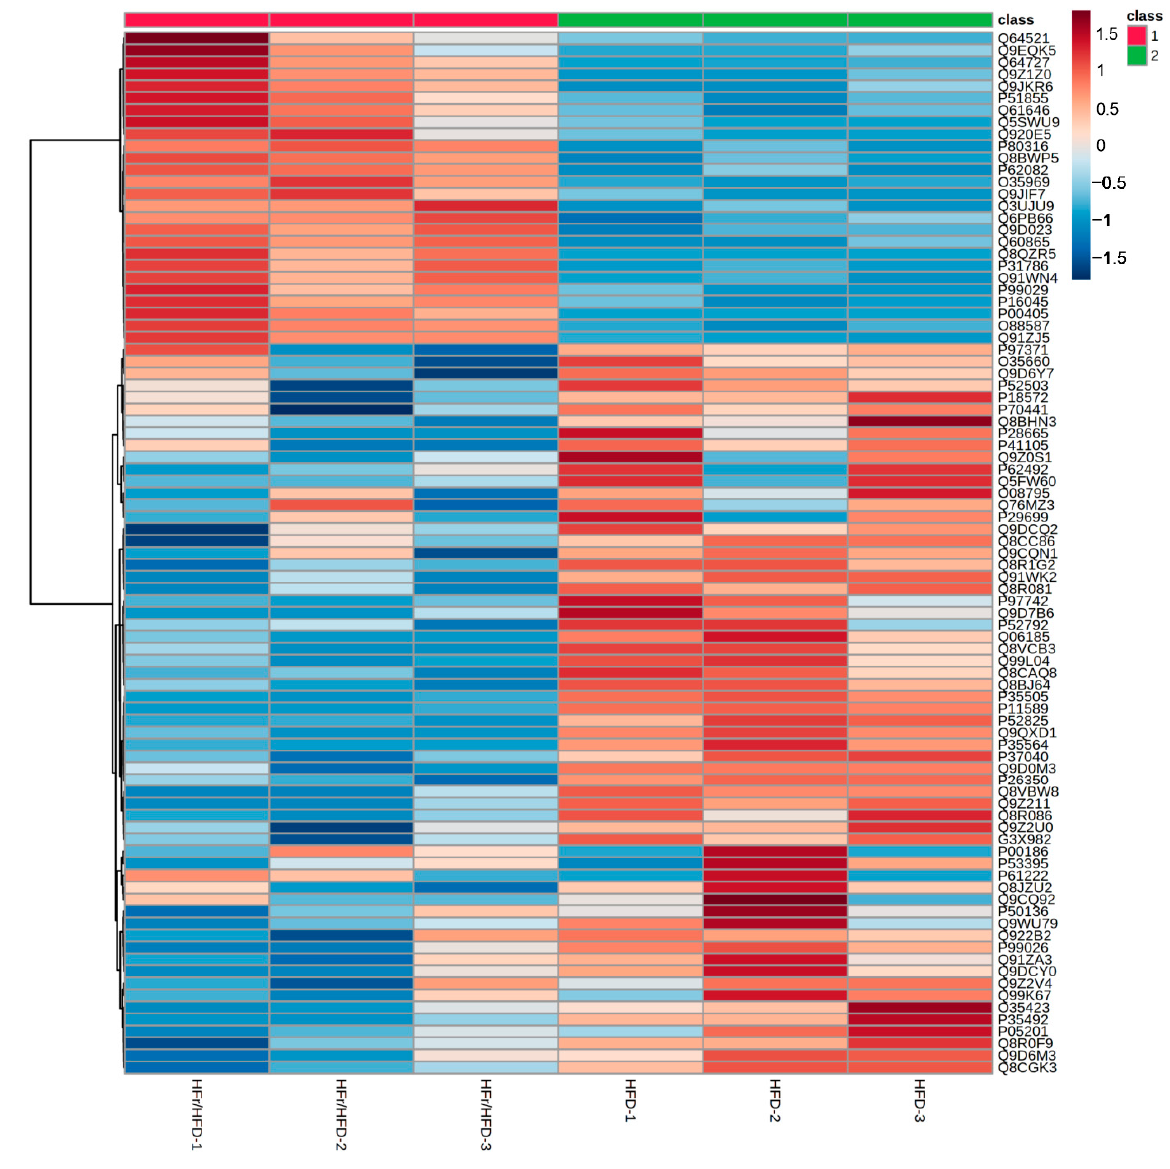
Figure 4. Heatmap of proteins identified in liver tissues from mice of the HFD and HFr/HFD groups. Data were obtained from 3 mice in each group. The intensities of proteins were processed with log10 transformation and presented in colors, ranging from red to blue. Red indicates protein upregulation and blue indicates protein downregulation in the HFr/HFD group, compared with the HFD group. HFD: high-fat diet group. HFr/HFD: high-fat diet plus 30% fructose in drinking water group.